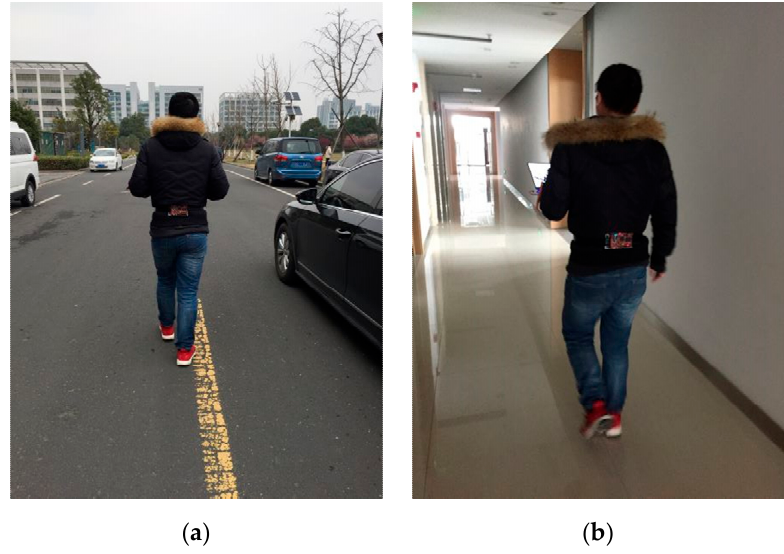
Figure 9. Test data collection in different scenes: ( a ) outdoor tests; ( b ) indoor tests.